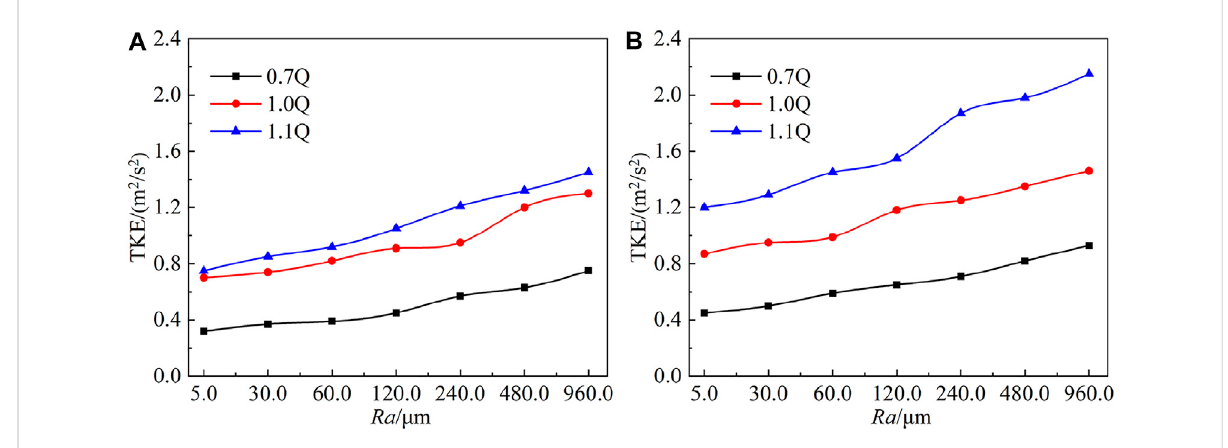
FIGURE 16 Variations of turbulent kinetic energy with different Ra values: (A) pressure surface and (B) suction